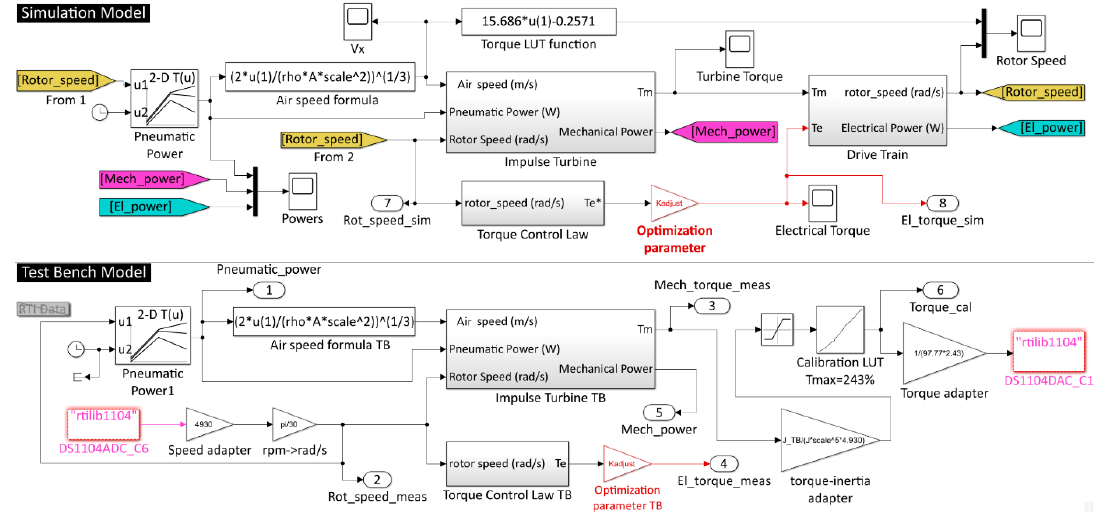
Figure 13. Simulink model of the electric PTO with an MPPT control law.